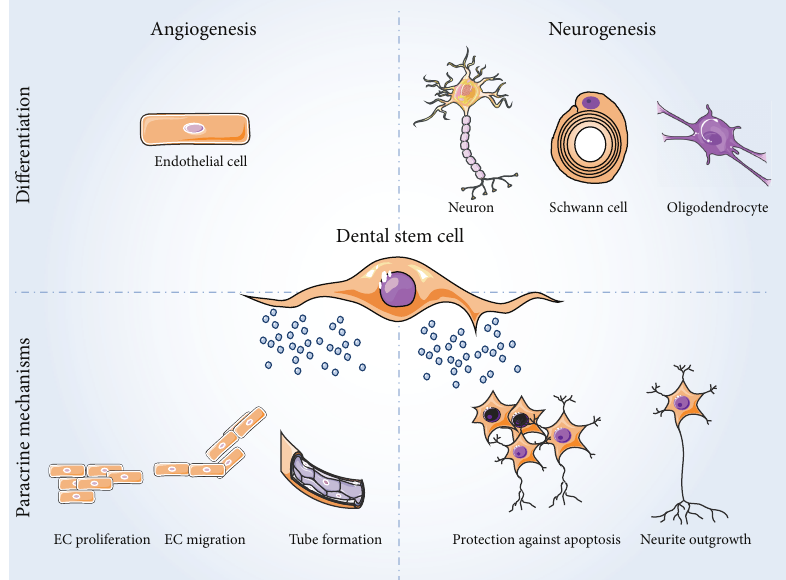
Figure 1: General overview of the angiogenic and neurogenic potential of DSCs. DSCs can differentiate into endothelial cells, neurons, Schwanncells,andoligodendrocytesunderspecificenvironmentalclues.MorerelevantfortheirclinicalapplicationsisthefactthatDSCshave a secretome rich in proteins which have a beneficial effect on surrounding cells. DSCs secrete a wide variety of angiogenic factors, inducing endothelial cell proliferation, migration, tube formation, and thus blood vessel development. DSCs also express neurotrophic factors which protect neurons from apoptosis and induce neurite outgrowth. This figure was made with images from the Servier Medical Art by Servier.